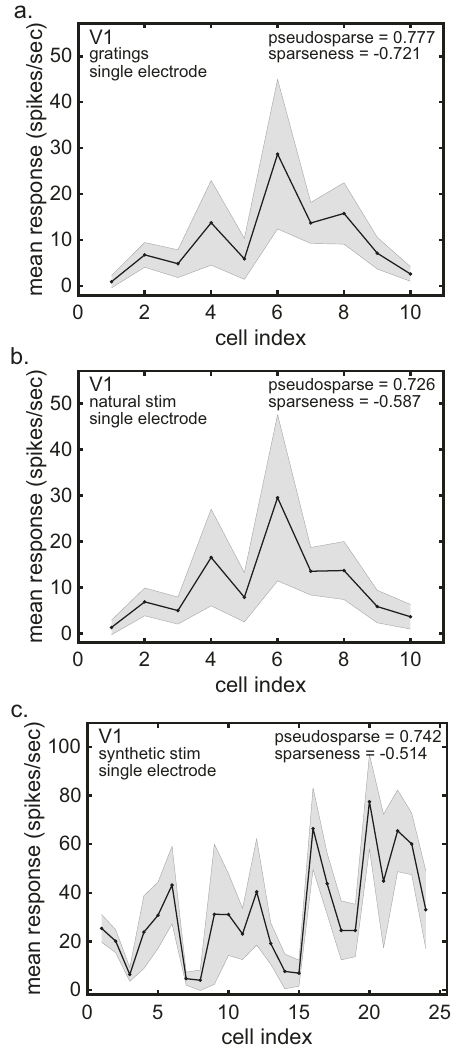
Fig. 3 Response spectra for V1 using single-electrode data. a Response spectrum using grating stimuli. N = 10 neurons with n = 416 stimuli per neuron. b Response spectrum using natural stimuli. N = 10 neurons with n = 540 stimuli per neuron. Neurons in a and b are the same. These single- electrode data were synthesized from multielectrode data (Data from Coen-Cagli et al. 29 ). c Response spectrum using synthetic stimuli. N = 24 neurons with 157 stimuli per neuron (Data from Lehky et al. 14,31 ). Gray error bars represent standard